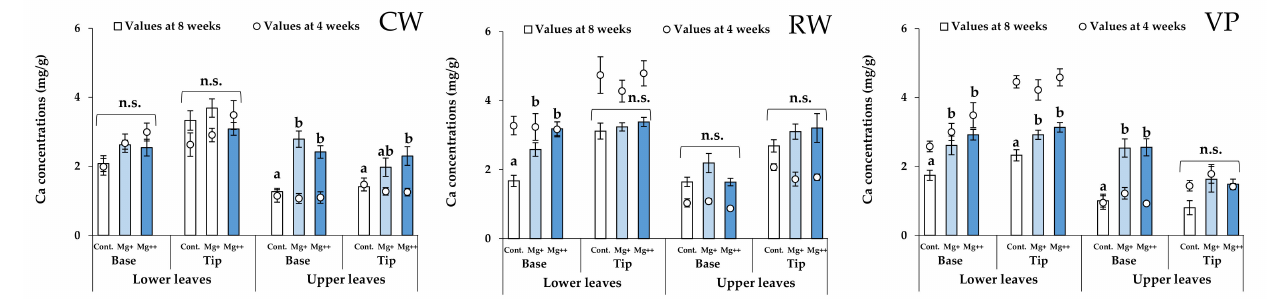
Figure 6. Ca concentrations in the base and tip of the lower and upper leaves in each treatment group and each cultivar at 4 (scatter plots) and 8 weeks (bar graph). Data are means ± SE. Significant differences among means are indicated by different letters. n.s. represents no significant differences among the treatment groups. Cultivars: Celeb Wine (CW), Reina White (RW), and Voyage Peach